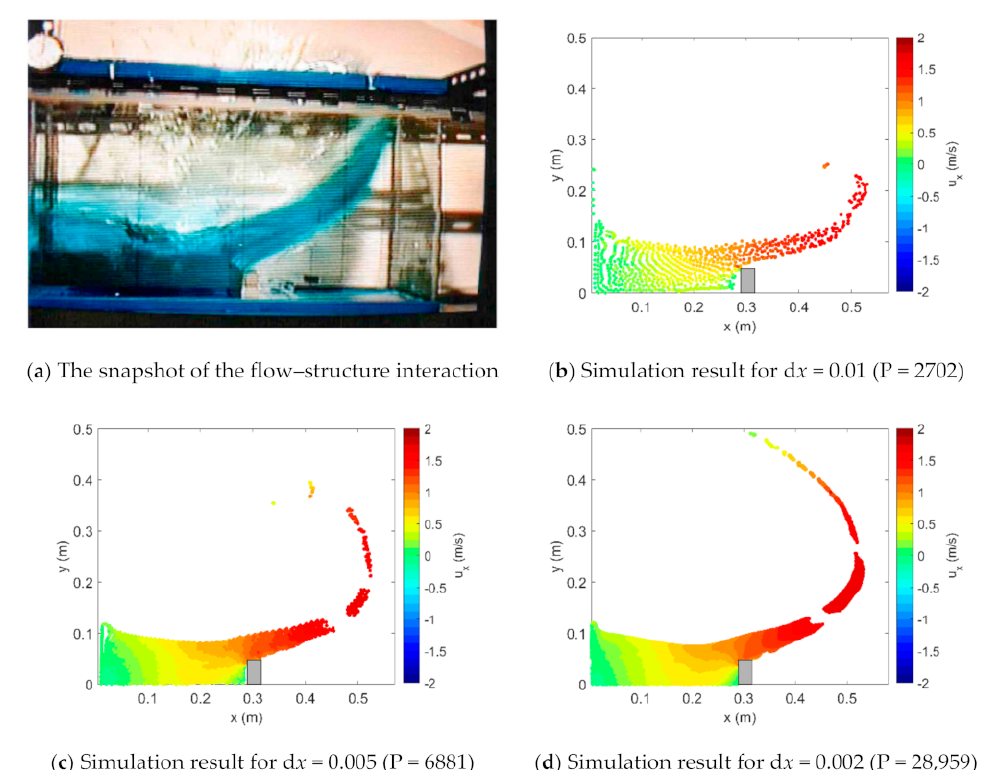
Figure 6. Validation and convergence studies of the presented SPH model. ( a ) is the snapshot of the flow–structure interaction from the experiment implemented by [61]. The image was reproduced from [62] which is similar to the CFW condition in this study; ( b – d ) are the SPH simulations of this study at 3 s after dam breaking; d x is the particle size and P is the particle